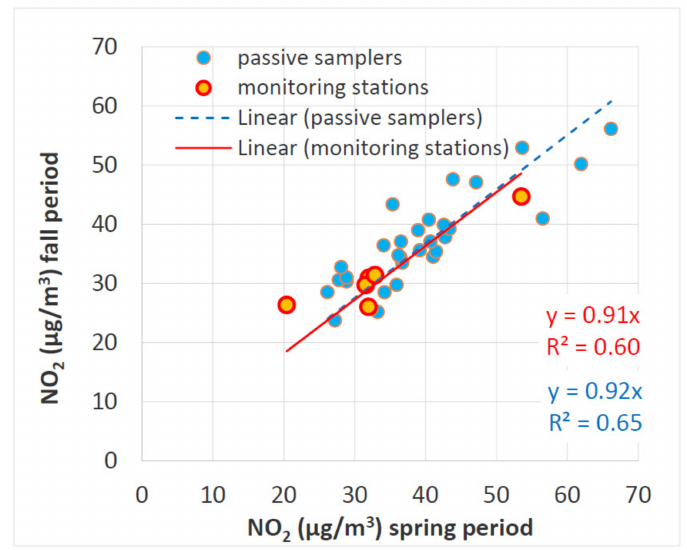
Figure 4. Comparison of spring and fall NO 2